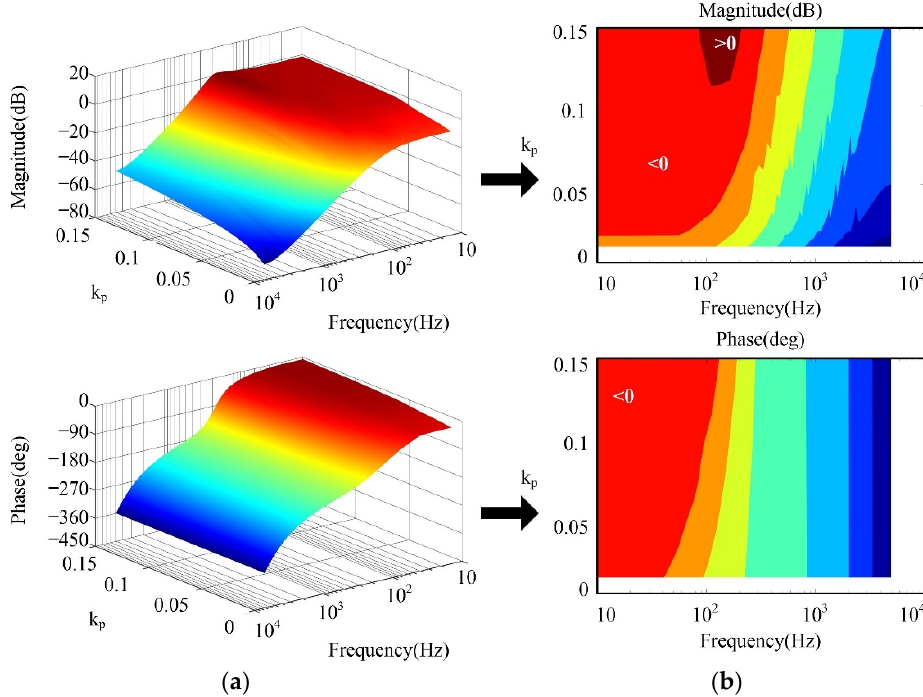
Figure 6. Frequency characteristics of G m ( z ): ( a ) Three-dimensional image; ( b ) Two-dimensional image.